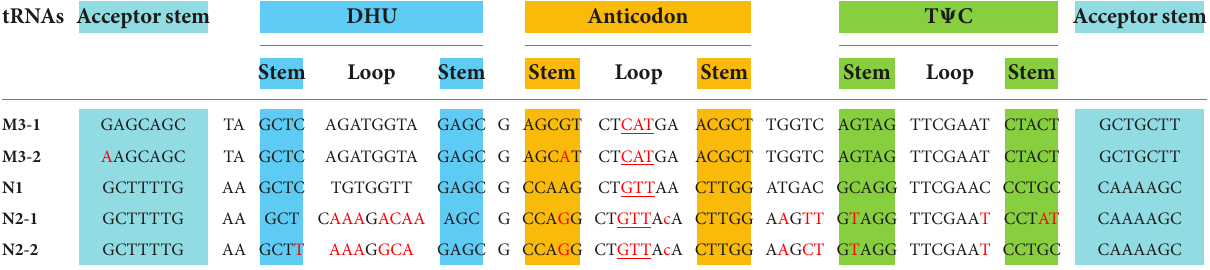
*Circularplasmidincludedtheintegratedplasmidin Ume1 to Ume3 ,andthestandaloneplasmidin Ume4 and Ume5 . **Theintergenicregionsharboredspecificgenesincluding rpo s,specificfree-standing orf sandtRNAgenes.